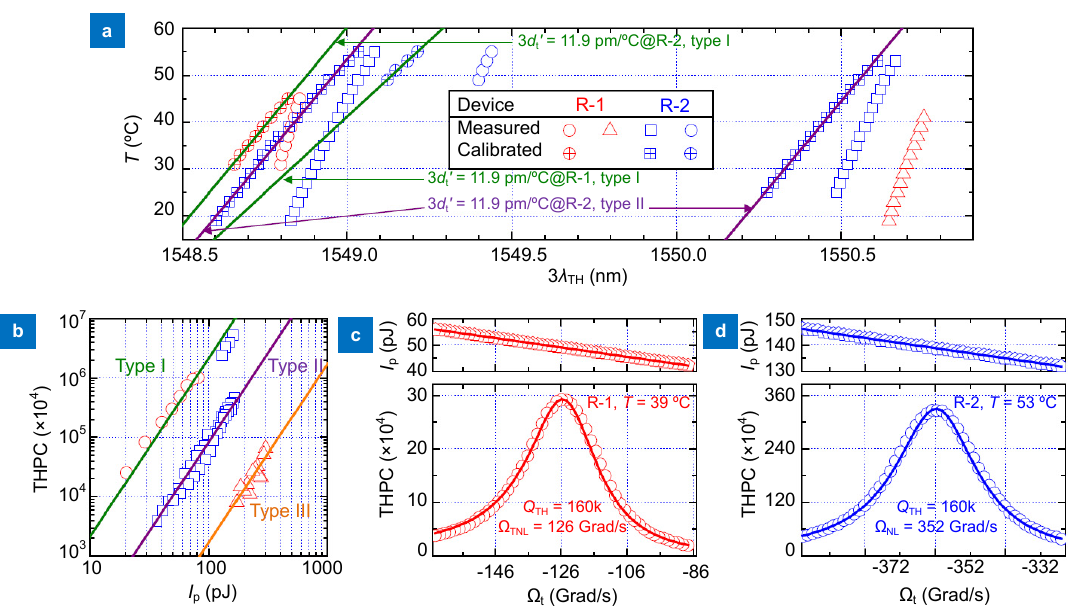
Fig. 3. | ( a ) Measured pump wavelength corresponding to the peak resonances of three types of TM TH modes. The calibrated cold-cavity reso- nance wavelengths were obtained by subtracted Ω TNL which are shown in plus center symbols. The calibrated TDWS of Type I (green lines) and Type II (purple lines) TH modes are also shown. ( b ) Measured third harmonic photon counts (THPC) on the resonance peaks of the TH modes as a function of I p showing the cubic TH-pump relationship. The solid lines show the cubic TH-pump relationship for comparison. ( c – d ) The meas- ured I p (upper) and filter response (lower) of corresponding type I TH modes as functions of Ω t in the devices of R-1 (c) and R-2 (d) respectively. The Q-factor of TH modes Q TH can be indirectly determined by using Θ t = 2.55×10 9 rad/pJ into Eq. (4). The corresponding fitted curves using estimated Q TH are also shown in (c) – (d). Here, the symbols of the measured data in (b) – (d) are the same as those in (a). Table 1 | The corresponding parameters of Figs. 3(a) and 3(b). Details of corresponding pump mode parameter measurement are dis- cussed in Supplementary information.